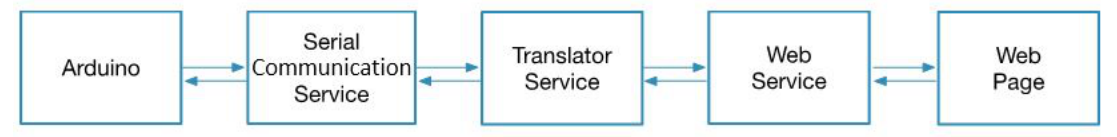
Figure 2. Choreography